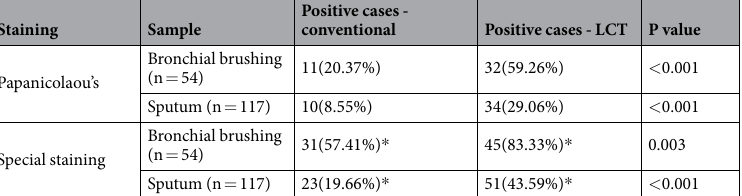
Table 2. Results of conventional and liquid-based cytopathology. LCT: liquid-based cytopathology test. * P < 0.05 vs Papanicolaou’s staining.